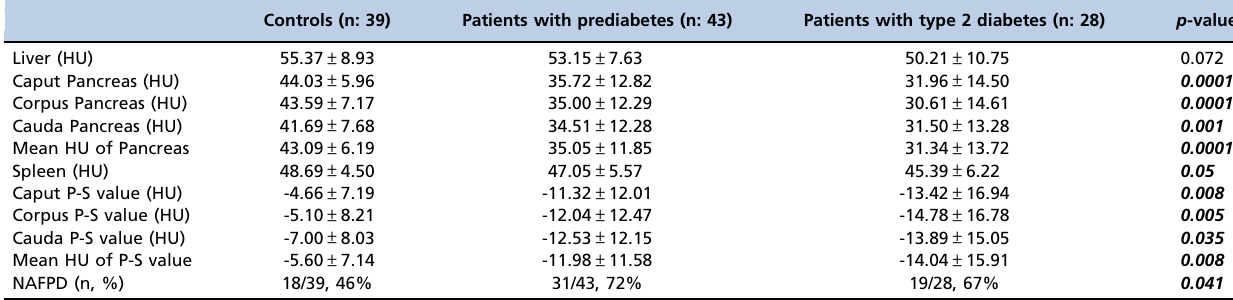
(HU: Hounsfield unit, P-S value: difference between HU values of part of pancreas and spleen, NAFPD: nonalcoholic fatty pancreas disease, n: number of patients) (statistically significant p -values were expressed in bold and